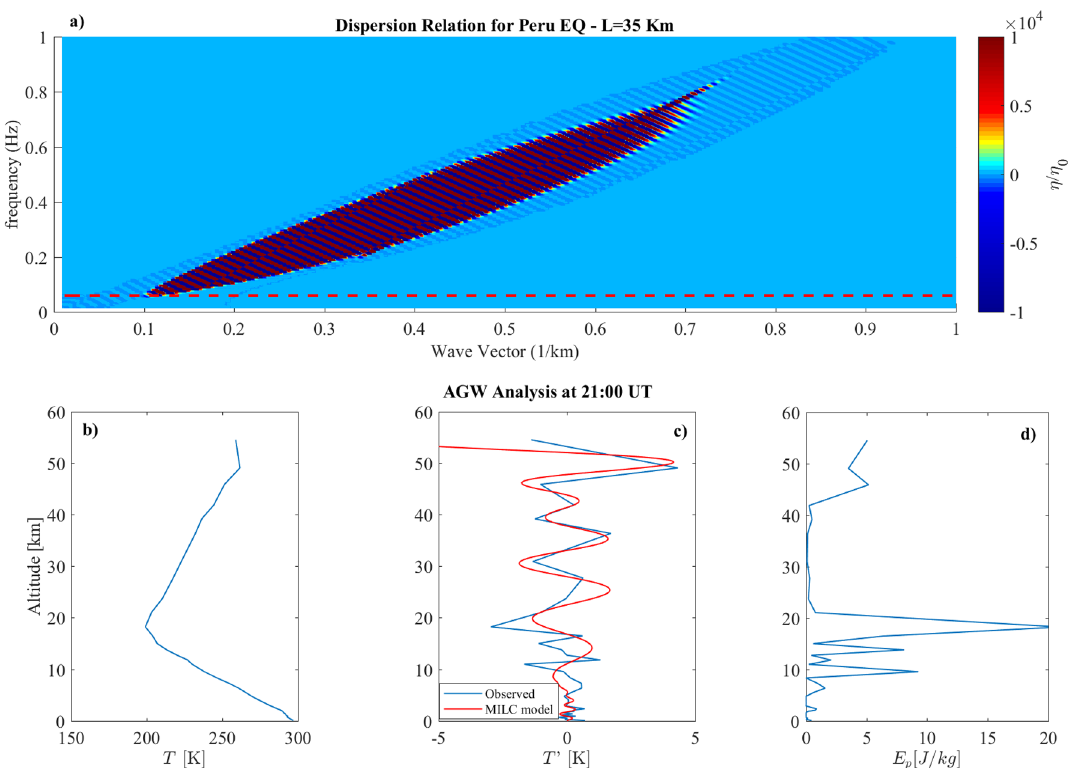
Figure 3. ( a ) Dispersion Relation evaluated for the Peru Earthquake using the parameters in Table 1. The dashed line represents the parameter c 0 / 2 h . ( b ) Vertical Temperature profile over the EQ epicenter. ( c ) comparison between fluctuations of the vertical temperature profile observed (blue line) and modelled (red line) over the EQ epicenter. ( d ) Potential energy density vertical profile over the EQ.